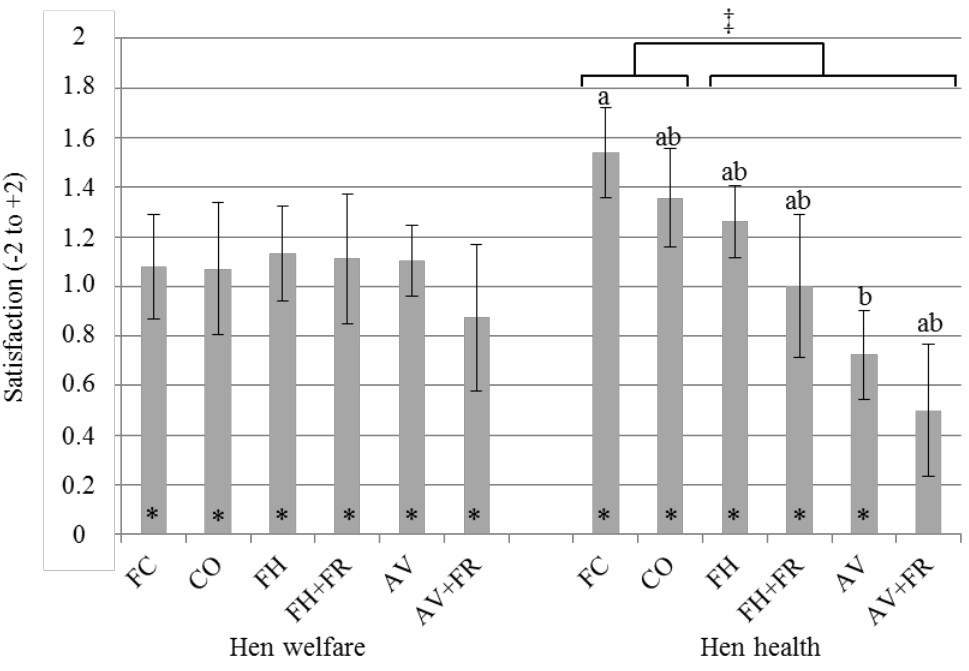
Figure 2. Satisfaction with hen welfare and health per housing system (n = 96). Satisfaction was (cid:1) scored on a scale of 2 (very unsatisfied) to +2 (very satisfied). Asterisks indicate a significant difference from the neutral score (0). Housing systems without a common superscript differ ( p < 0.05). ‡ indicates a significant difference between cage vs. non-cage systems ( p = 0.015). FC = furnished cages, CO = colony cages, FH = floor housing, FH + FR = floor housing + free-range access, AV = aviary, AV + FR = aviary + free-range